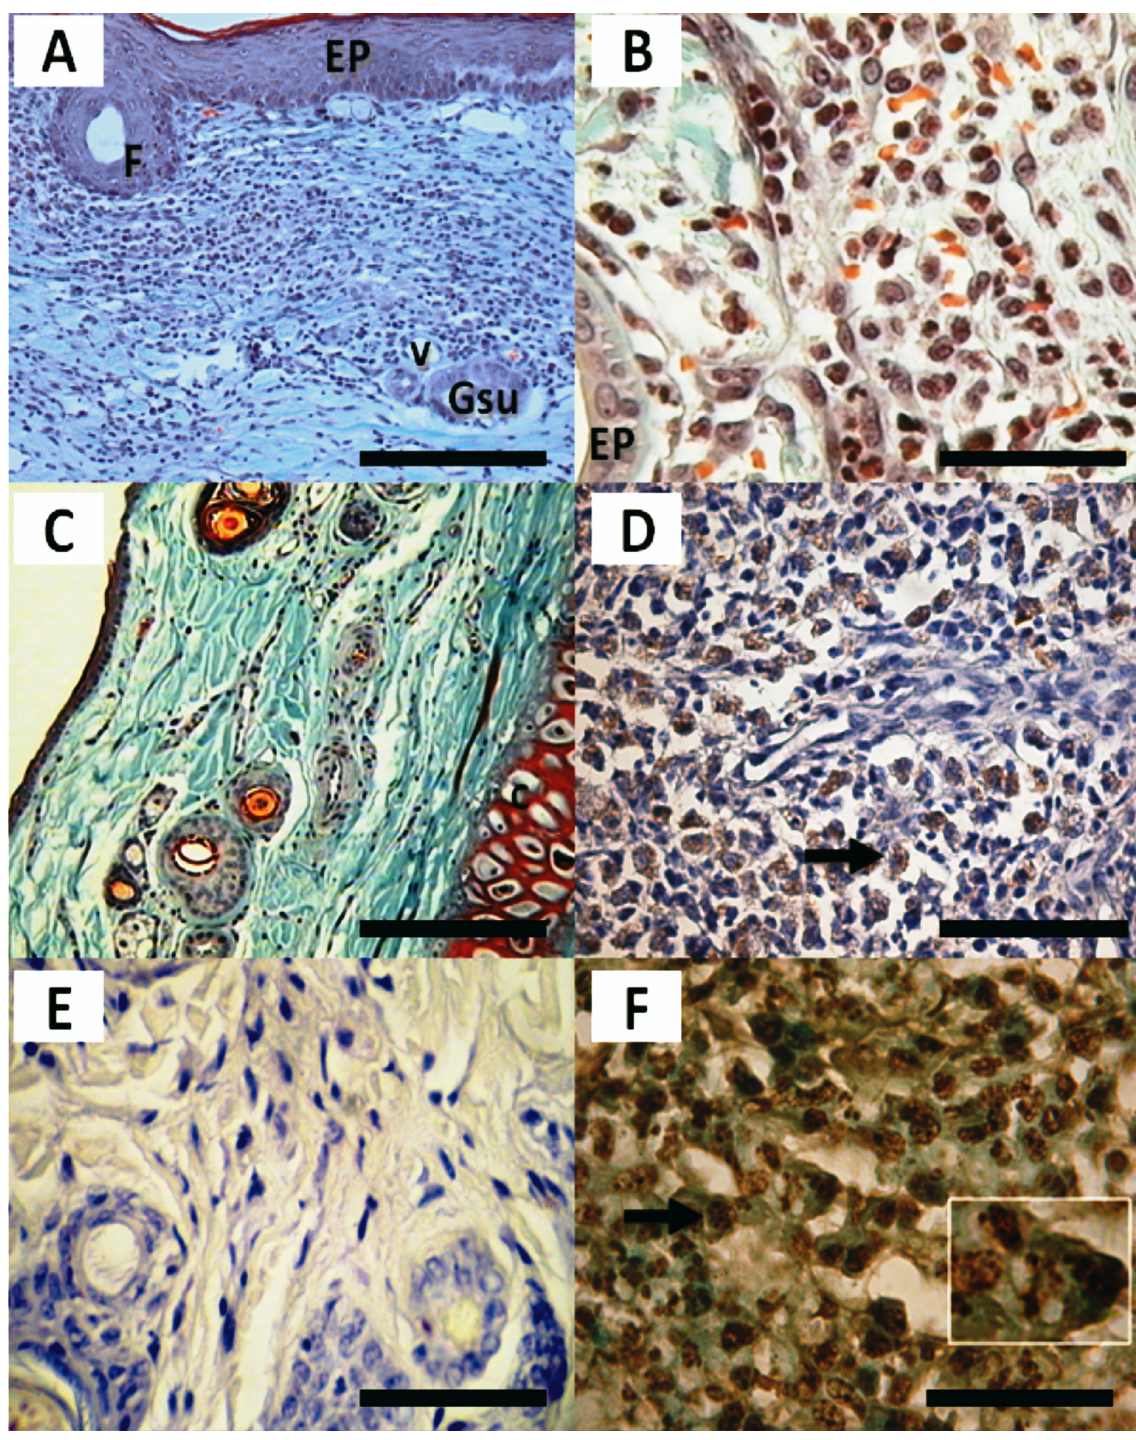
Figure 2. Representative histological sections (5 μm) of ear skin samples from dogs affected by canine leishmaniasis. ( A ) Symptomatic dogs: moderate, multifocal, perivascular, subepidermal and periglandular inflammatory infiltrates. Shorr’s trichrome stain. Bar: 100 μm. ( B ) Symptomatic dogs: focal and subepidermal inflammatory infiltrates with neutrophils and macrophages. Shorr’s trichromic stain. Bar: 25 μm. ( C ) Asymptomatic dogs: mild, multifocal perivascular and perifollicular inflammatory infiltrates. Shorr’s trichrome stain. Bar: 100 μm. ( D ) Symptomatic dogs: amastigotes within macrophages (black arrow), immunohistochemical test for Leishmania chagasi detection. Immunoperoxidase staining. Bar: 25 μm. ( E ) Asymptomatic dogs: absence of amastigotes forms of the parasite, immunohistochemical test for Leishmania chagasi detection. Imunoperoxidase staining. Bar: 25 μm. ( F ) Symptomatic dogs: AgNORs within nuclei of inflammatory cells (black arrows, small brown circular or oval structures) and apoptotic bodies (seen in detail below left). AgNOR staining. Bar: 25 μm. EP: keratinized stratified squamous epithelium, F: follicle, V: blood vessel (arteriole), Gsu: sweat gland, C: hyaline cartilage, Gse: sebaceous